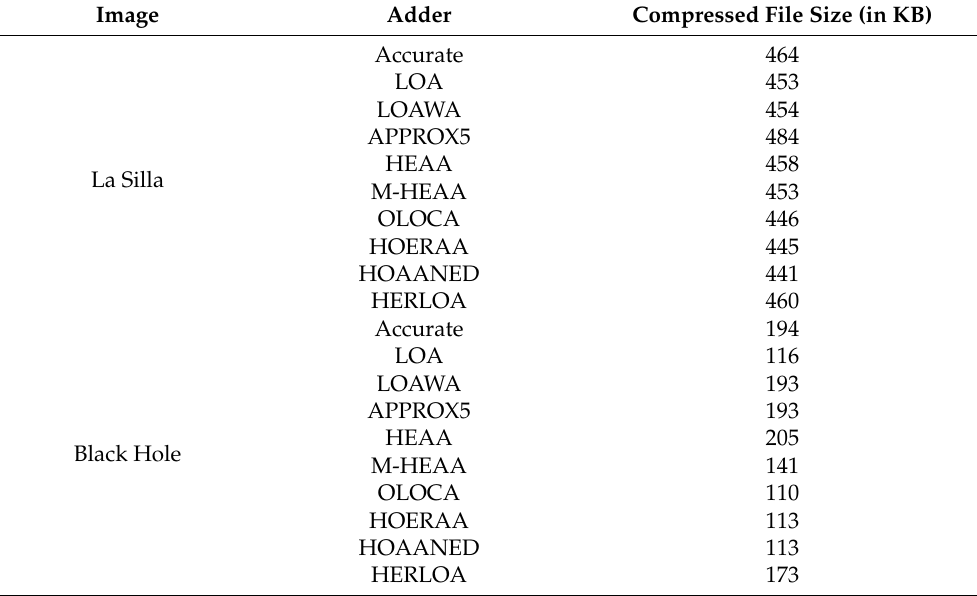
Table 1. Compressed file sizes of La Silla and Black Hole images corresponding to accurate adder and various approximate adders comprising an 11-bit inexact